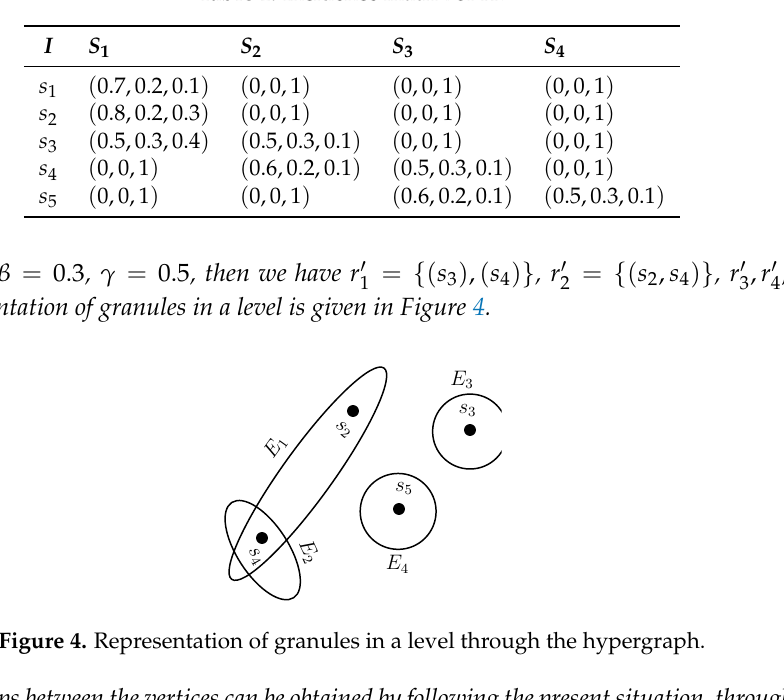
Figure 3. Hypergraph representation of granules. Table 1. Incidence matrix of H .